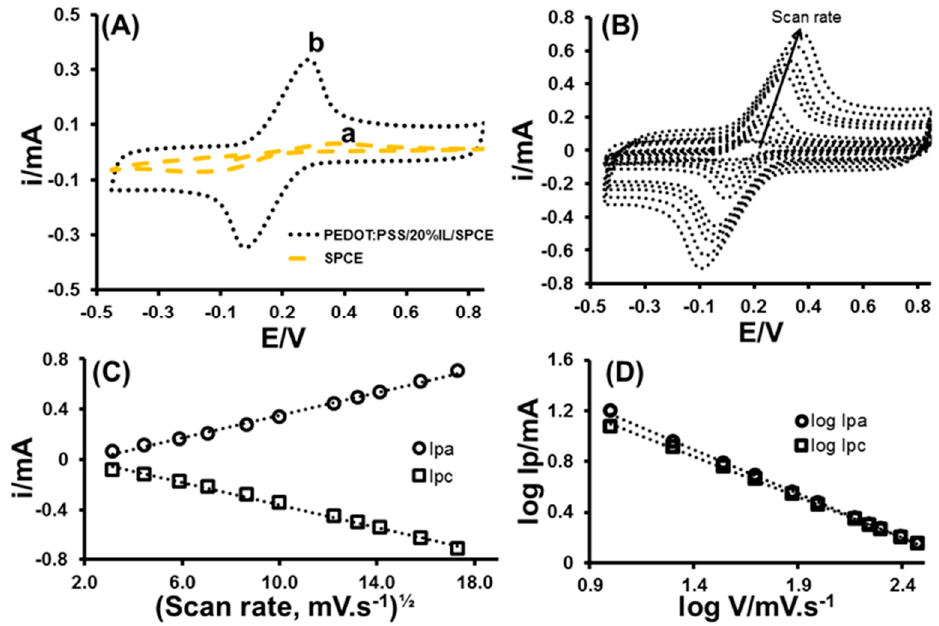
Figure 2. ( A ) Cyclic voltammograms recorded using SPCE (curve a) and PEDOT:PSS/20%IL/SPCE sensor (curve b) at 100 mV · s − 1 scan rate; ( B ) CVs recorded using PEDOT:PSS/20%IL/SPCE sensor at 10, 20, 35, 50, 75, 100, 150, 175, 200, 250, and 300 mV · s − 1 scan rates; ( C ) Peak current vs. square root of scan rate; ( D ) log I p vs. log V . All CVs were recorded in 5.0 mM hexacyanoferrate ([Fe(CN) 6 ] 3 − /[Fe(CN) 6 ] 4 − ) in PBS (pH 7.4) containing 0.1 M KCl.